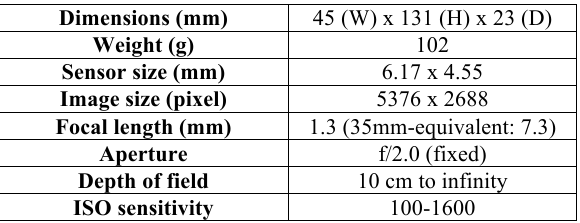
Table 1. Main technical specifications of Ricoh Theta SC (source: